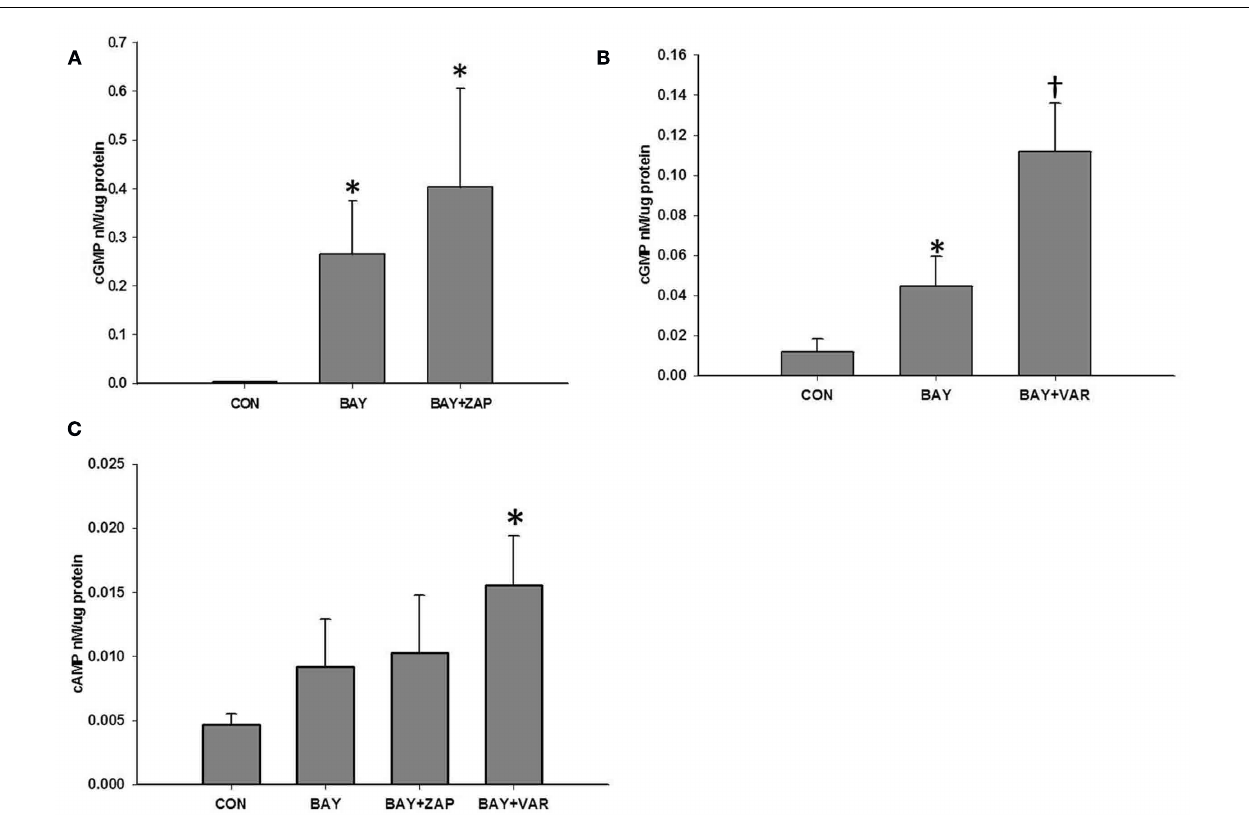
( n = 7).Values are the means ± SE. *Different from control ( P < 0.05); † different from all other values ( P < 0.05). (C) Effect of vardenafil (VAR) or zaprinast (ZAP) on BAY-induced increases in cAMP.VSMCs were pretreated with ZAP (10 μ M, n = 11),VAR (50nM, n = 7), or vehicle for 30min prior to stimulation with BAY (10 μ M) for 60min.Values are the means ± SE. *Different from control ( P < 0.01).